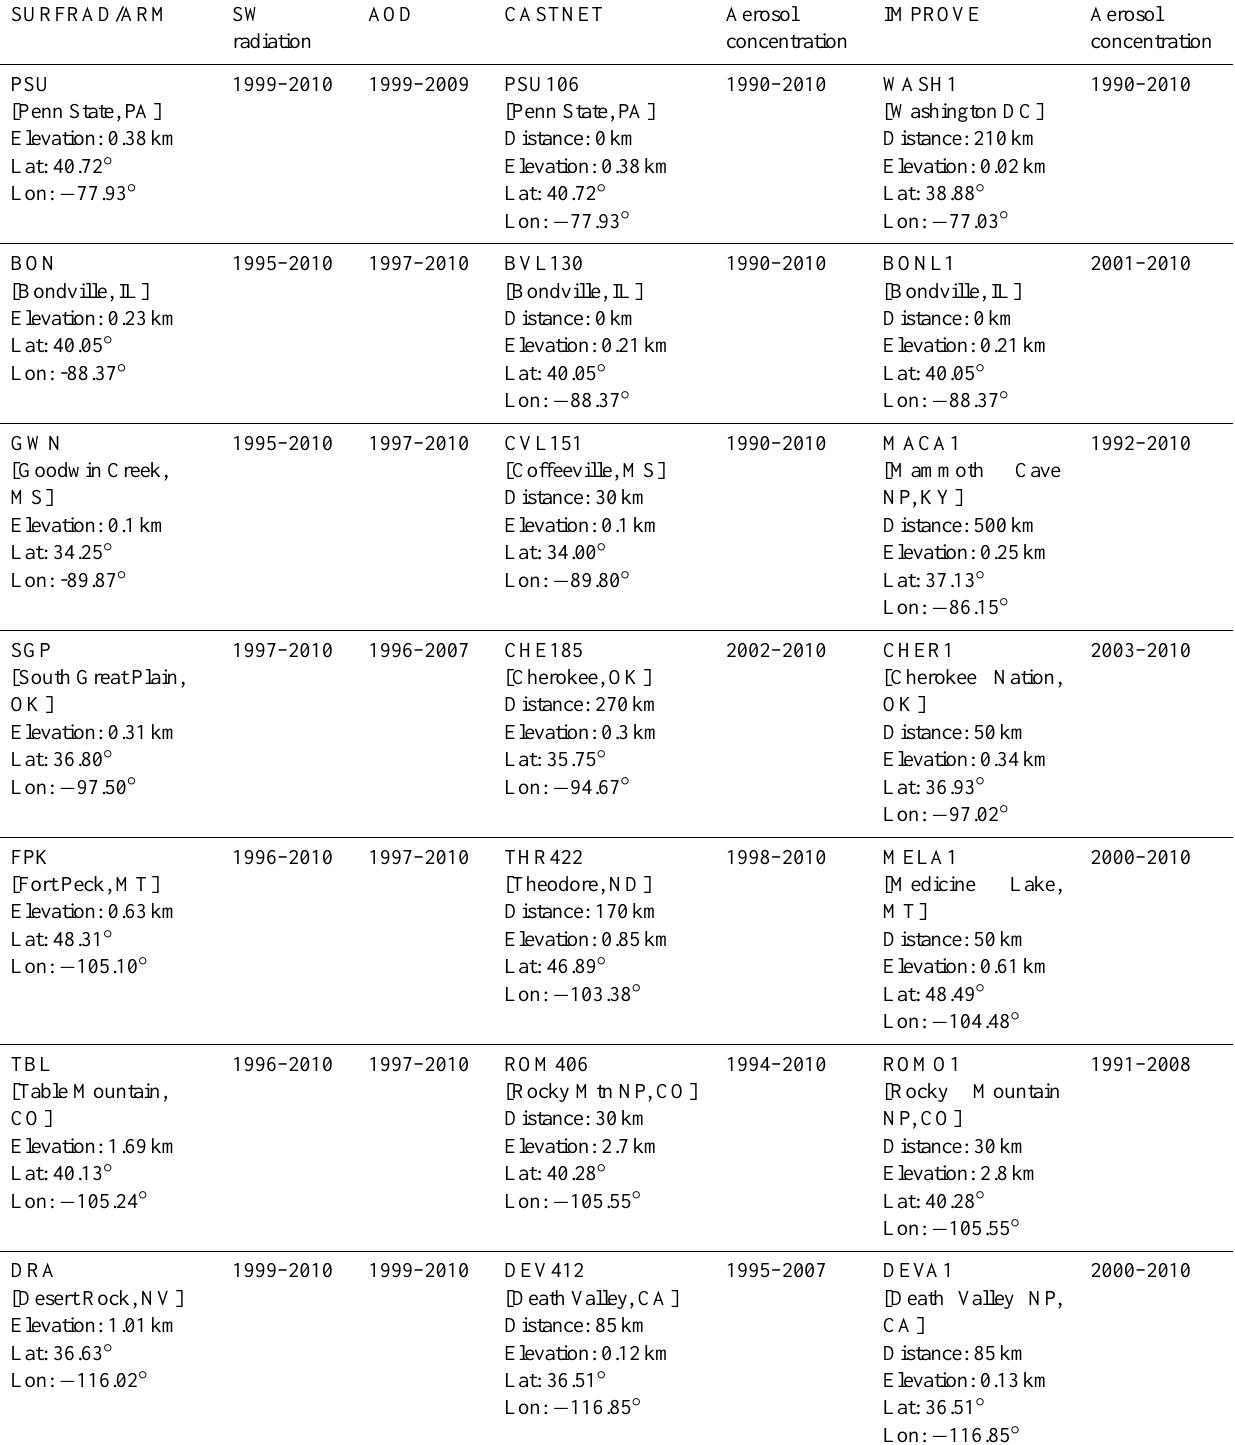
Table 1. Listing of site identification of each site for the different networks and their measurement period used in this study. Distance means the approximate distance between SURFRAD/ARM sites and CASTNET or IMPROVE sites.